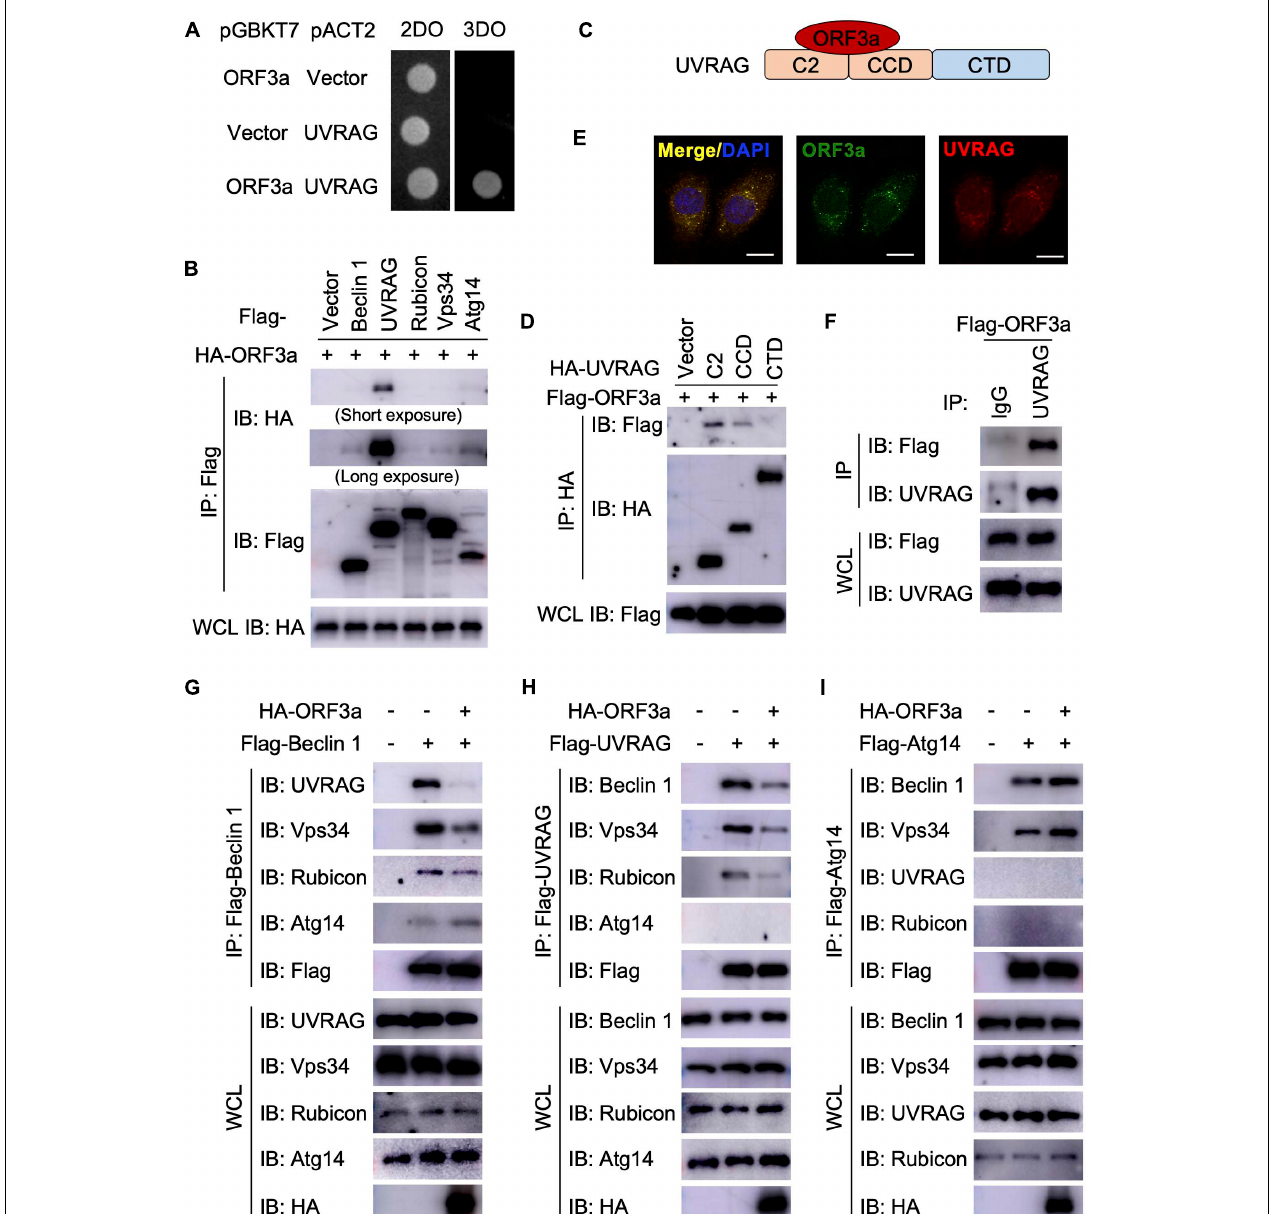
FIGURE 2 | Severe Acute Respiratory Syndrome Coronavirus-2 ORF3a targets UVRAG to modulate PI3KC3 complex formation. (A) SARS-CoV-2 ORF3a interacts with UVRAG in yeast two-hybrid system. (B) SARS-CoV-2 ORF3a binds to UVRAG in HEK293T cells. HEK293T cells were co-transfected with indicated plasmids and cell lysates were collected and subjected to immunoprecipitation (IP) and IB with indicated antibodies at 48 h post-transfection. (C) Schematic diagram of SARS-CoV-2 ORF3a-UVRAG interaction. (D) The C2 and CCD of UVRAG bind to SARS-CoV-2 ORF3a. (E) SARS-CoV-2 ORF3a co-localizes with endogenous UVRAG. HeLa-ORF3a stable cells were subjected to immunostaining with antibodies against Flag or UVRAG. Scale bar, 15 µ m. (F) SARS-CoV-2 ORF3a binds to endogenous UVRAG in HEK293T cells. (G–I) SARS-CoV-2 ORF3a blocks PI3KC3-C2 but facilitates PI3KC3-C1. HEK293T cells were co-transfected with indicated plasmids and cell lysates were collected and subjected to IP and IB with indicated antibodies at 48h